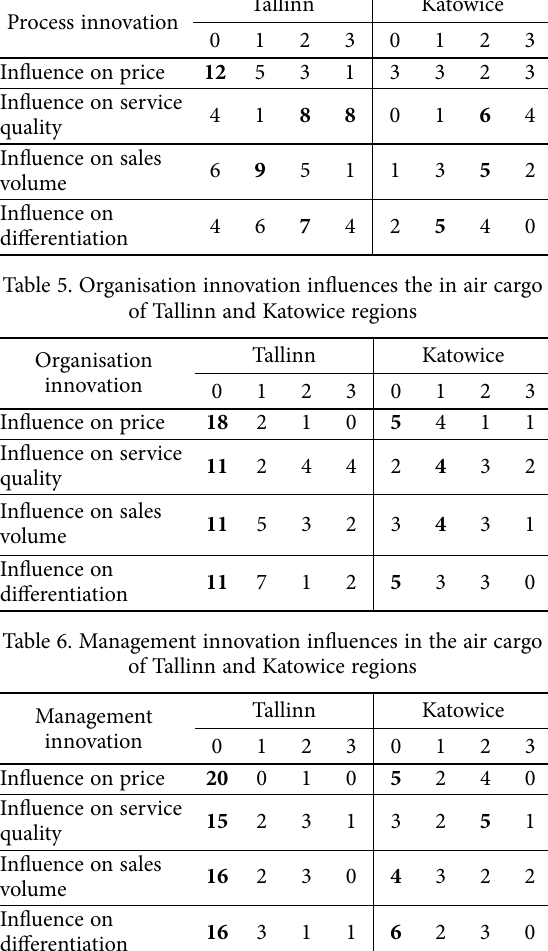
Table 4. Process innovation influences in the air cargo of Tallinn and Katowice regions